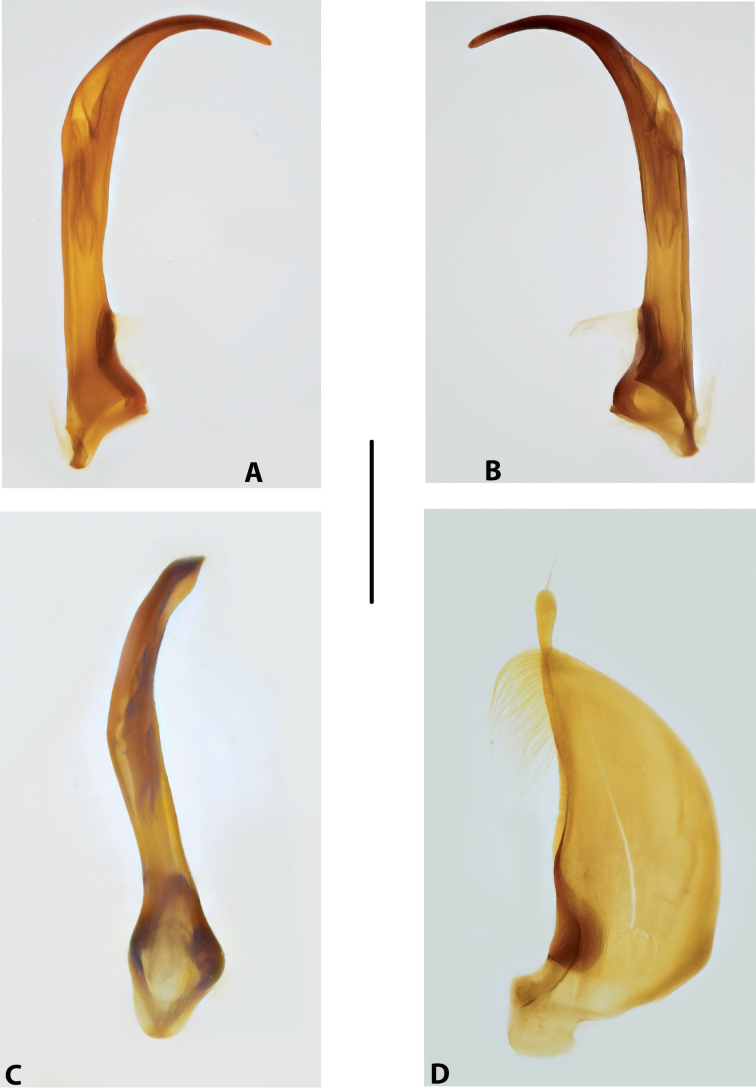
Copelatus
martinbaehri sp. nov., paratype from Mount Tozer A median lobe in lateral view, right side B median lobe in lateral view, left side C median lobe in ventral view D left paramere in external view. Scale bar: 0.5 mm.